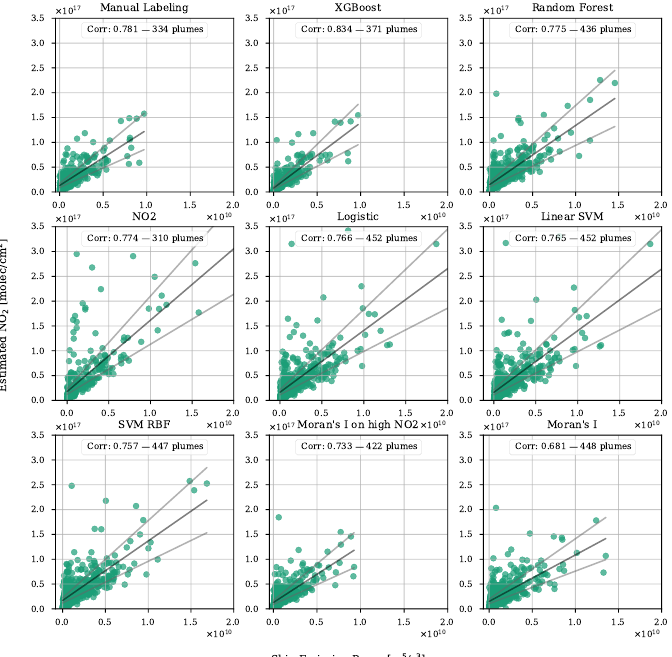
Figure 14. Pearson correlations between estimated (based on classification results) values of NO 2 emitted by each ship on a given day and a theoretical ship emission proxy. Black lines indicate a fitted linear trend. Grey lines show 30% deviations from the fitted linear